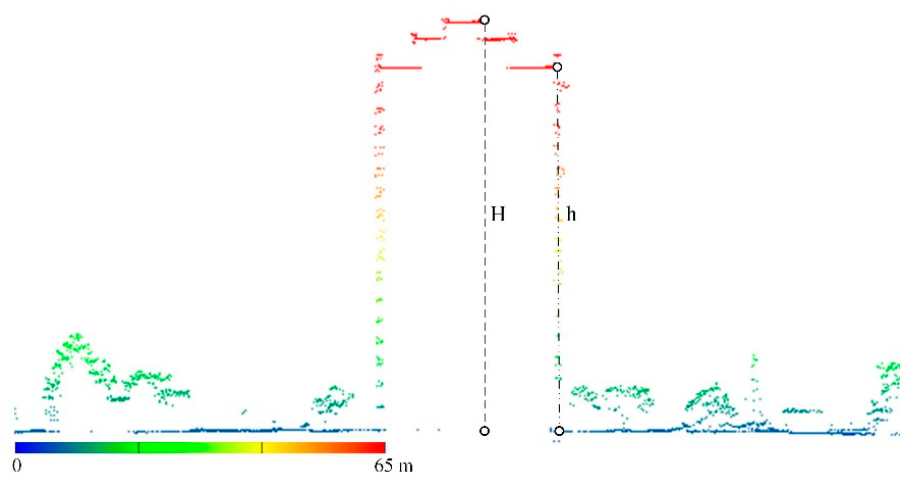
Figure 6. Representation of height from the main body of the building (h); and the total height of the building (H). building